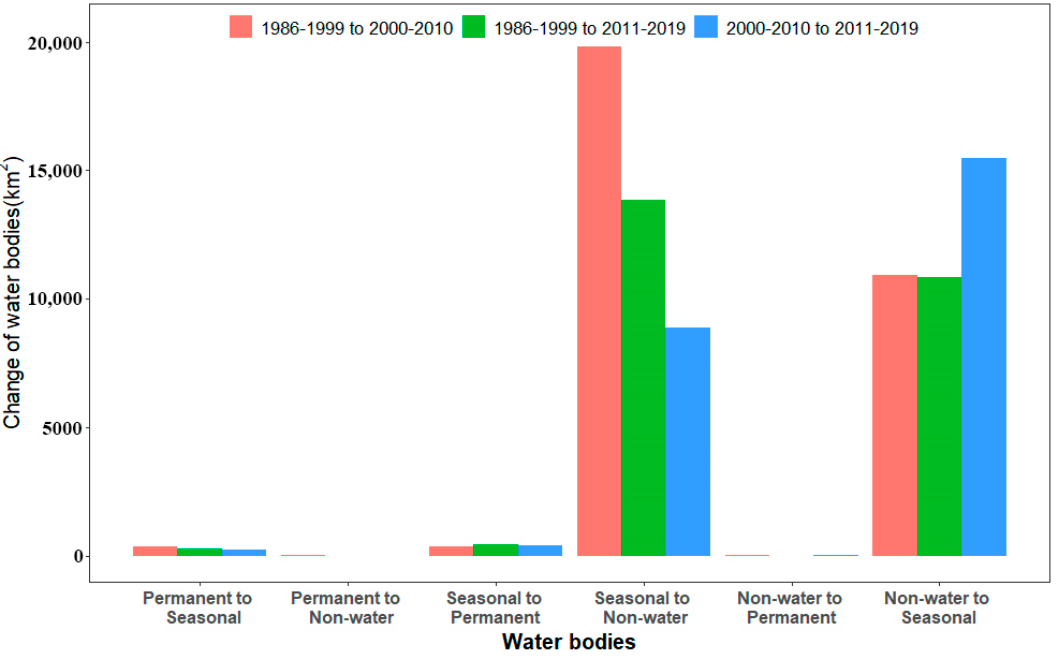
Figure 11. The conversion of open-surface water bodies in the